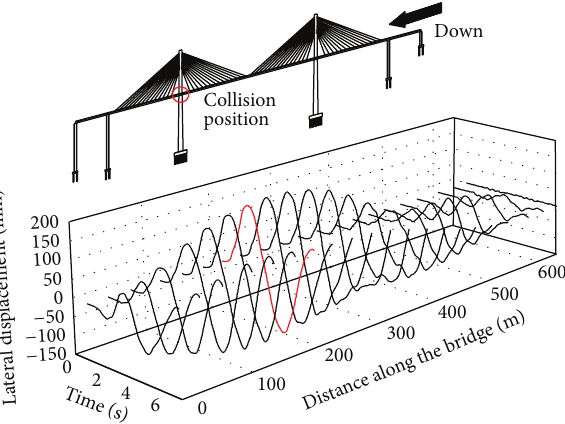
Figure 11: Lateral displacement field (in the down